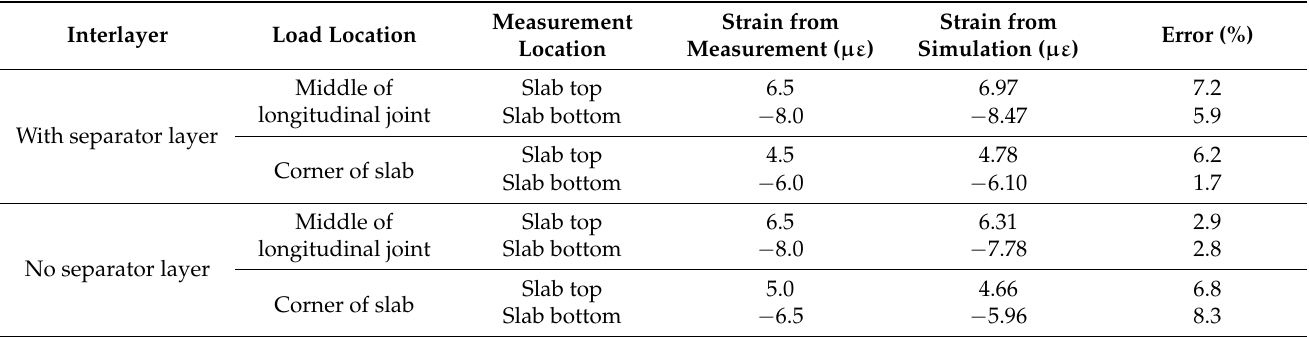
Table 6. Comparison of measured and simulated strain in concrete